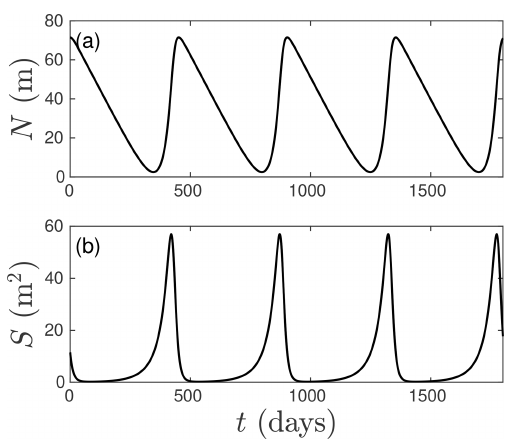
Figure 3. Periodic oscillations in the system (2) with param- eter values as in Table 1, with V p = 4km 2 , L = 50km and q in = 10.9m 3 s − 1 .